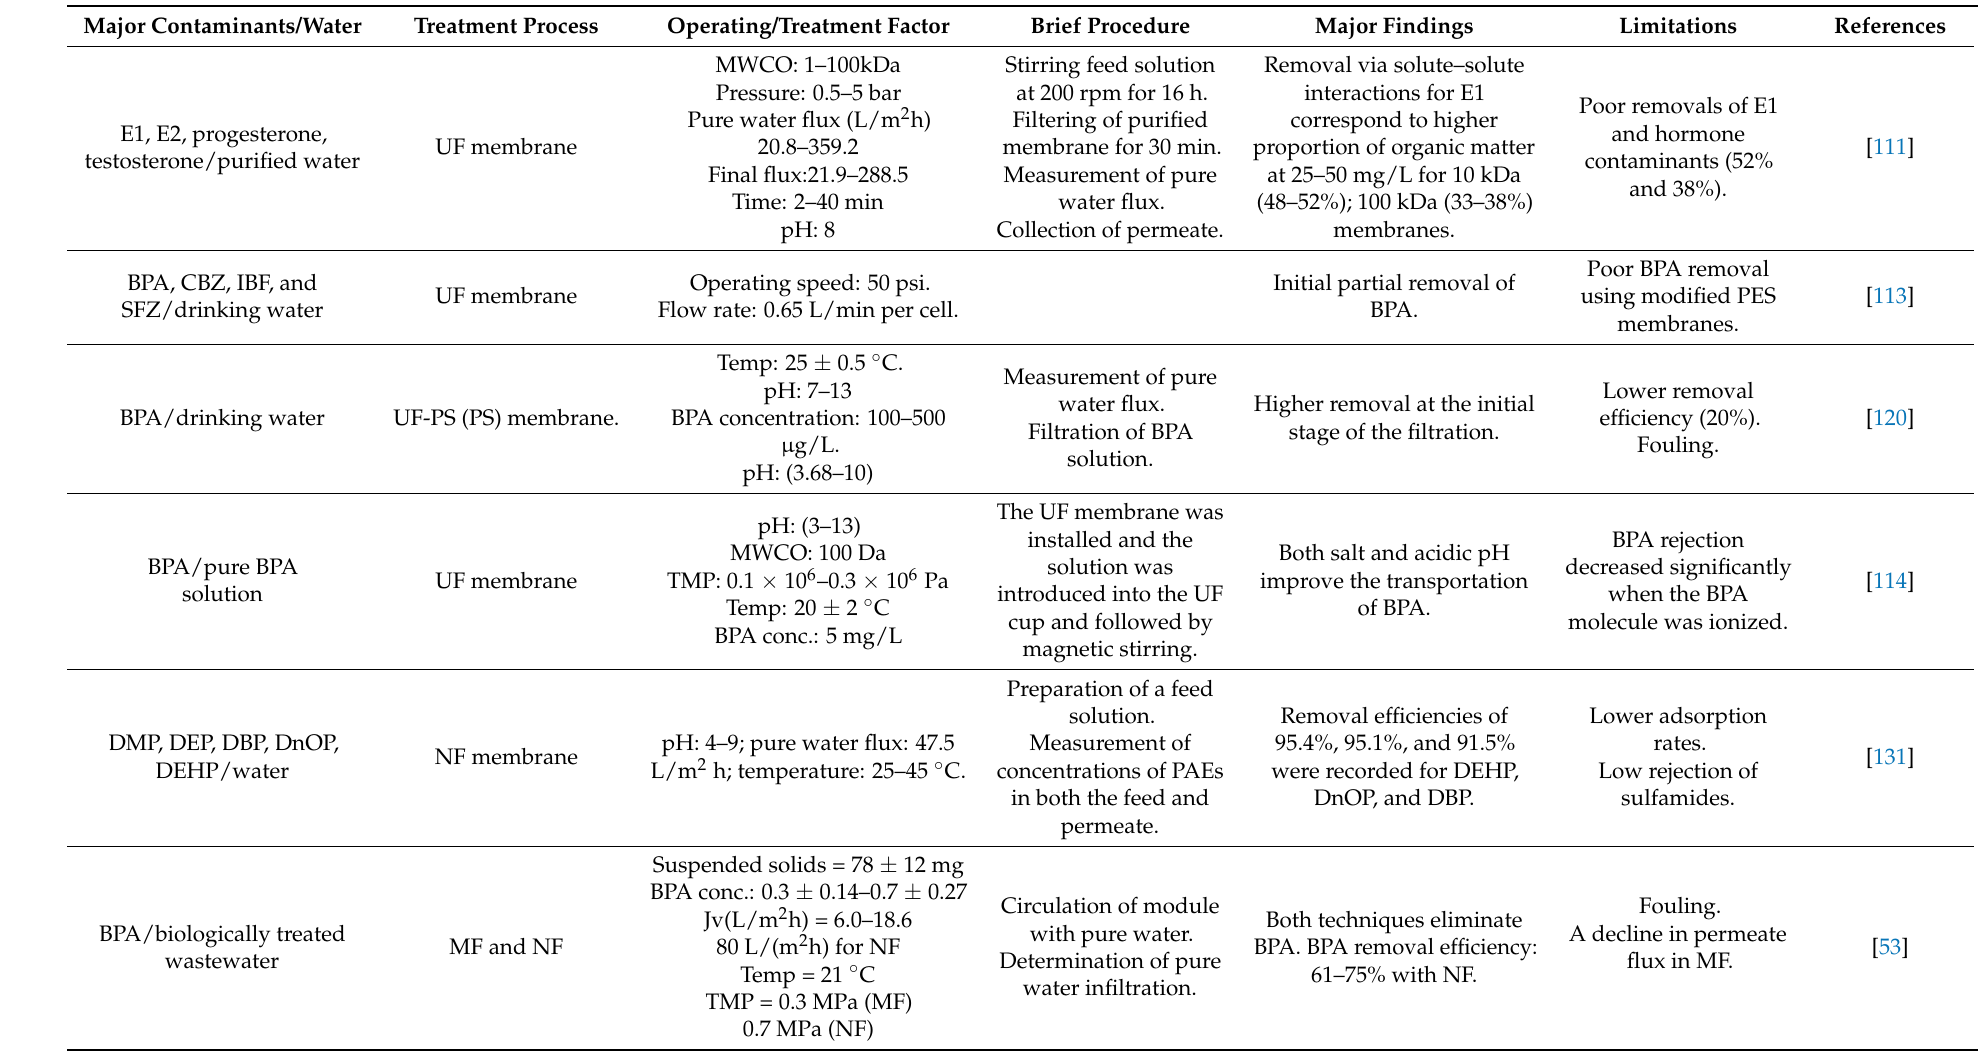
Table 4. Removal of EDCs by